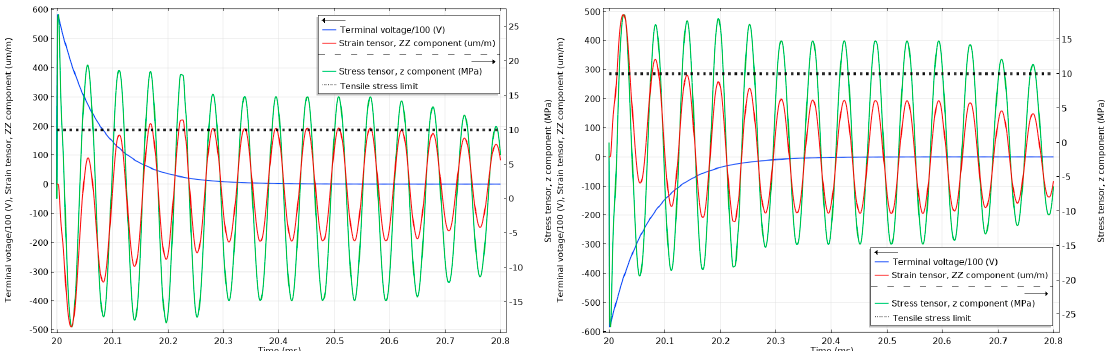
Figure 16. Stress and strain in the undamped stack when subjected to 1.2/50 µs 60 kV positive ( left ) and negative lightning impulses ( right ). The tensile stress limit of 10 MPa is marked by a black dotted line (the terminal voltage is the voltage applied to the top electrode of the stack.)